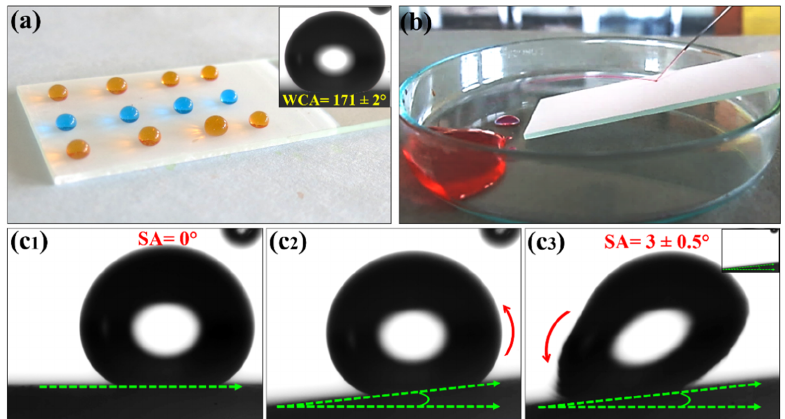
Figure 2. ( a ) Photograph of the color-dyed water drops on the superhydrophobic AD–2 coating. ( b ) The screenshot of the water jet hitting the superhydrophobic AD–2 coating. ( c1 – c3 ) The screenshots of the water droplet rolling on the superhydrophobic AD–2 coating.